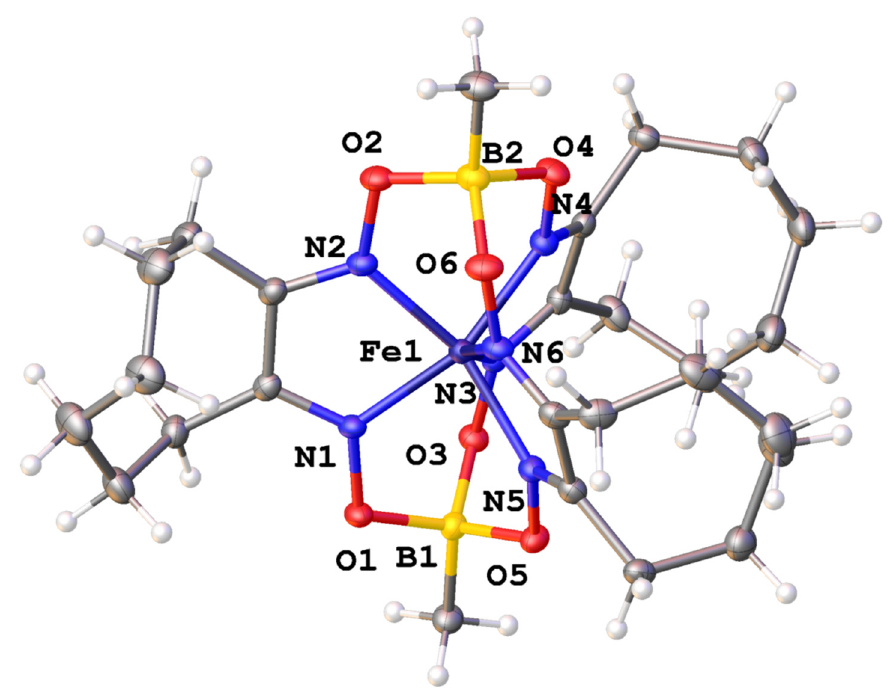
Figure 8. General view of the molecule FeOx 3 (BCH 3 ) 2 ( 5 ) in representation of its atoms with thermal ellipsoids ( p = 50%).